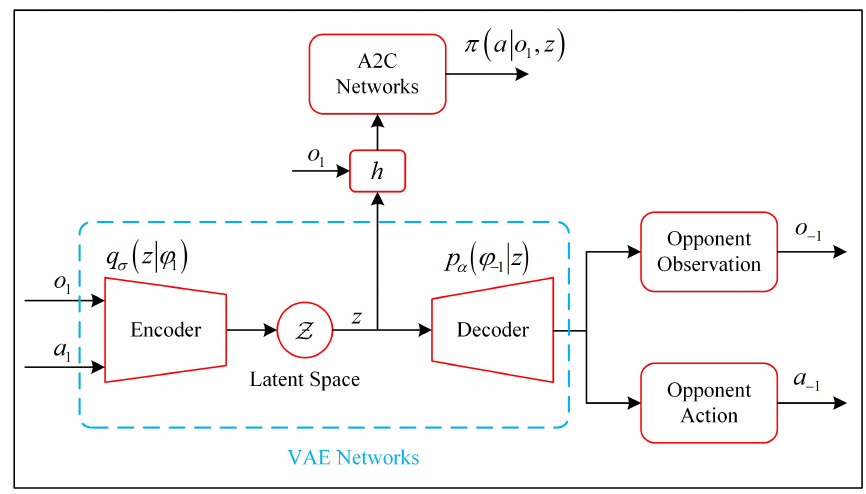
Figure 2. Diagram of offline learning